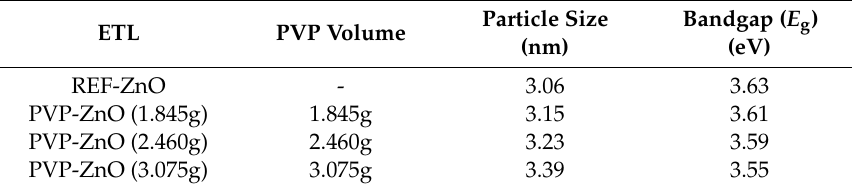
Table 1. Average particle size and bandgap variation of ZnO nanoparticles with PVP:Zn ratios.